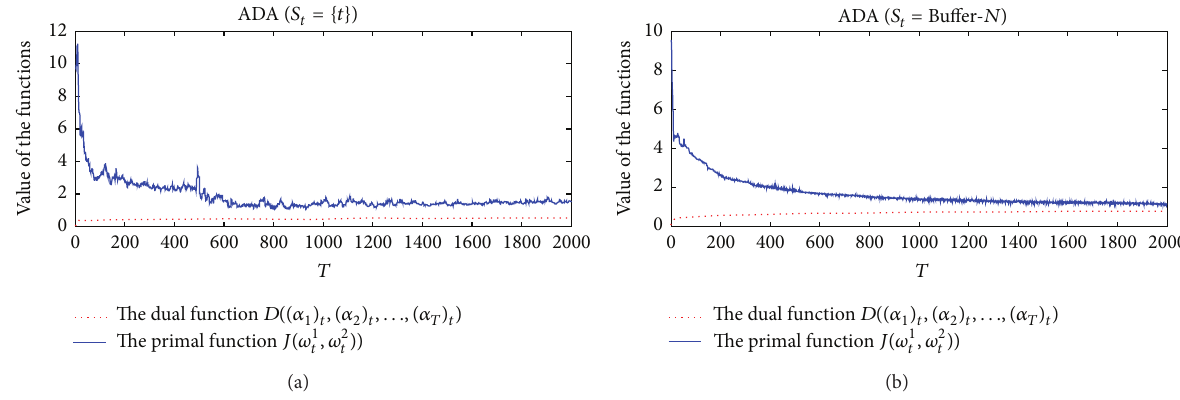
Figure 6: The value curves of the primal objective function and the dual function during the incremental learning process. From left to right (a) ADA ( 𝑆 𝑡 = {𝑡} ) and (b) ADA (Buffer- 𝑁 ). The two curves approach each other as 𝑡